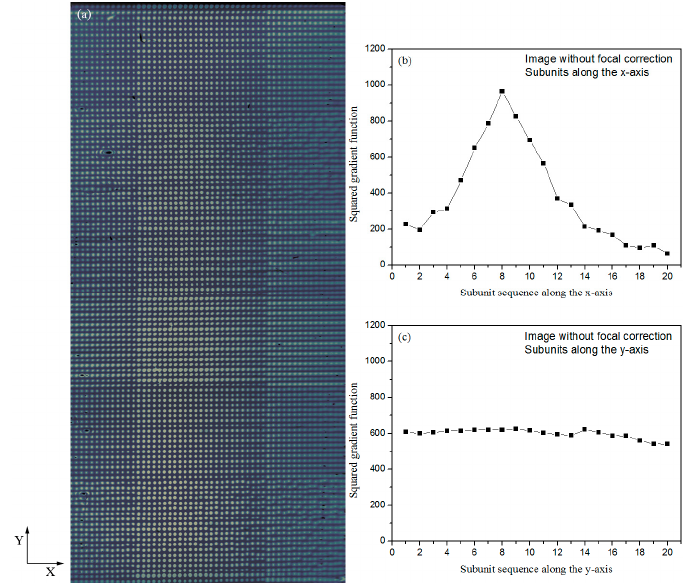
Figure 2. ( a ) A BBSA (biotin-conjugated bovine serum albumin) microarray image obtained with the TIR OI-RD microscope without focal correction. Image sharpness changes gradually along the x-axis; ( b ) Squared gradient functions of 20 subunits along the x -axis, each having 35 × 1500 pixels. The subunit sequence begins from the left side of the microarray image. The eighth subunit has the largest squared gradient function, indicating the best focusing in this region; ( c ) Squared gradient functions of 20 subunits along the y -axis, each having 710 × 75 pixels. The subunit sequence begins from the top of the microarray